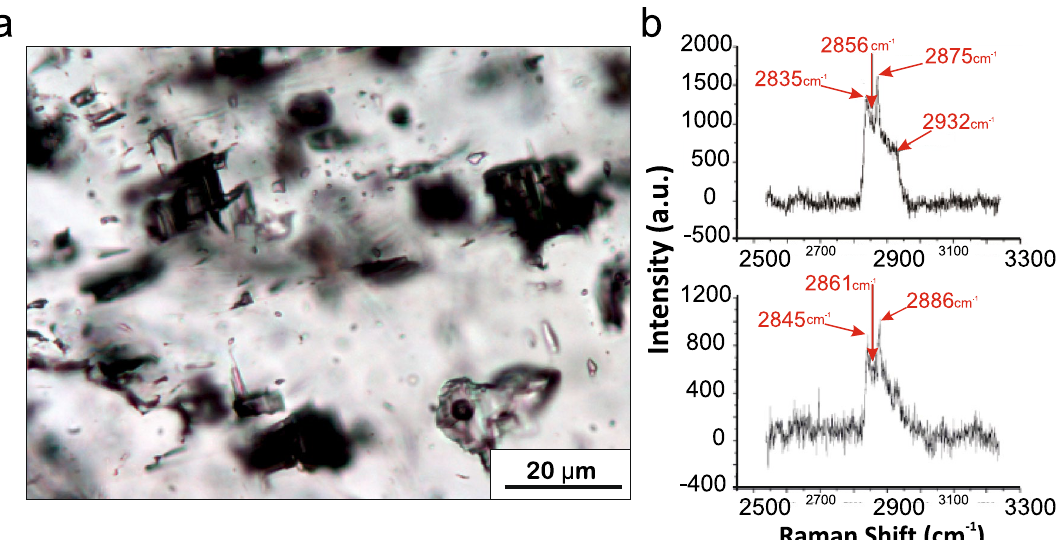
Figure 4. ( a ) Image of one (gas) and two (gas + liquid) phases fluid inclusions in sample JH-2. ( b ) Raman spectra showing evidence of the presence of hydrocarbons within samples JH-1 and